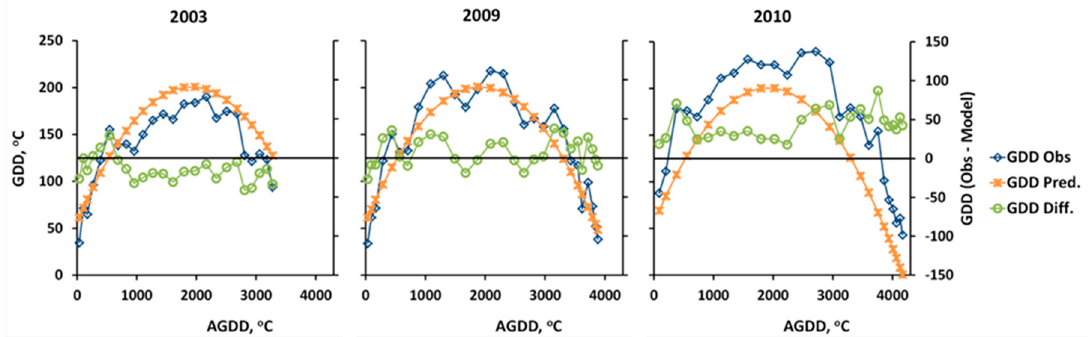
Figure 7. Line plots of annual observed GDD (blue), annual predicted GDD based on multi-year average model (orange) and observed GDD residuals (green) at Orenburg (RU) for: a cooler year (2003) ( left ); a close-to-average year (2009) ( center ); and a hotter year (2010) ( right ). N.B: GDDs are 8-day sums.